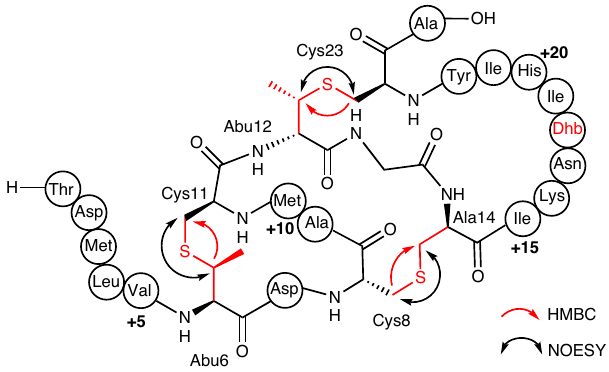
Fig.6|StructureofAspN-digestedproductoftheLanIIBGC. Schematicdiagram representing the ring pattern of the LanII product as determined by NMR, GC-MS, and HR-ESI MS/MS analysis. The black double-headed arrows and the red single- headed arrows represent characteristic NOESY and HMBC correlations across the thioetherbridges,respectively.Thenumbers+5,+10,+15and+20representamino acid positions in the core peptide beginning from the N-terminus. Modi fi ed amino acid residues are highlighted in